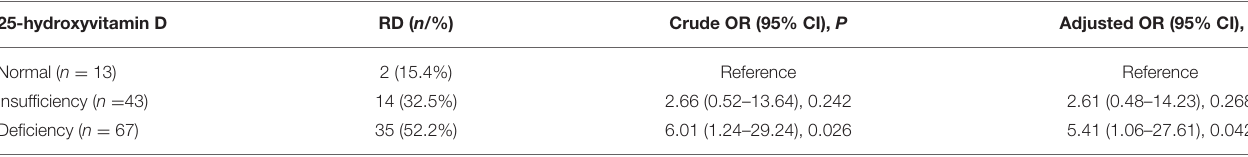
TABLE 3 | Multivariate analyses for the occurrence of RD after successful treatment of BPPV according to the 25-hydroxyvitamin D classification